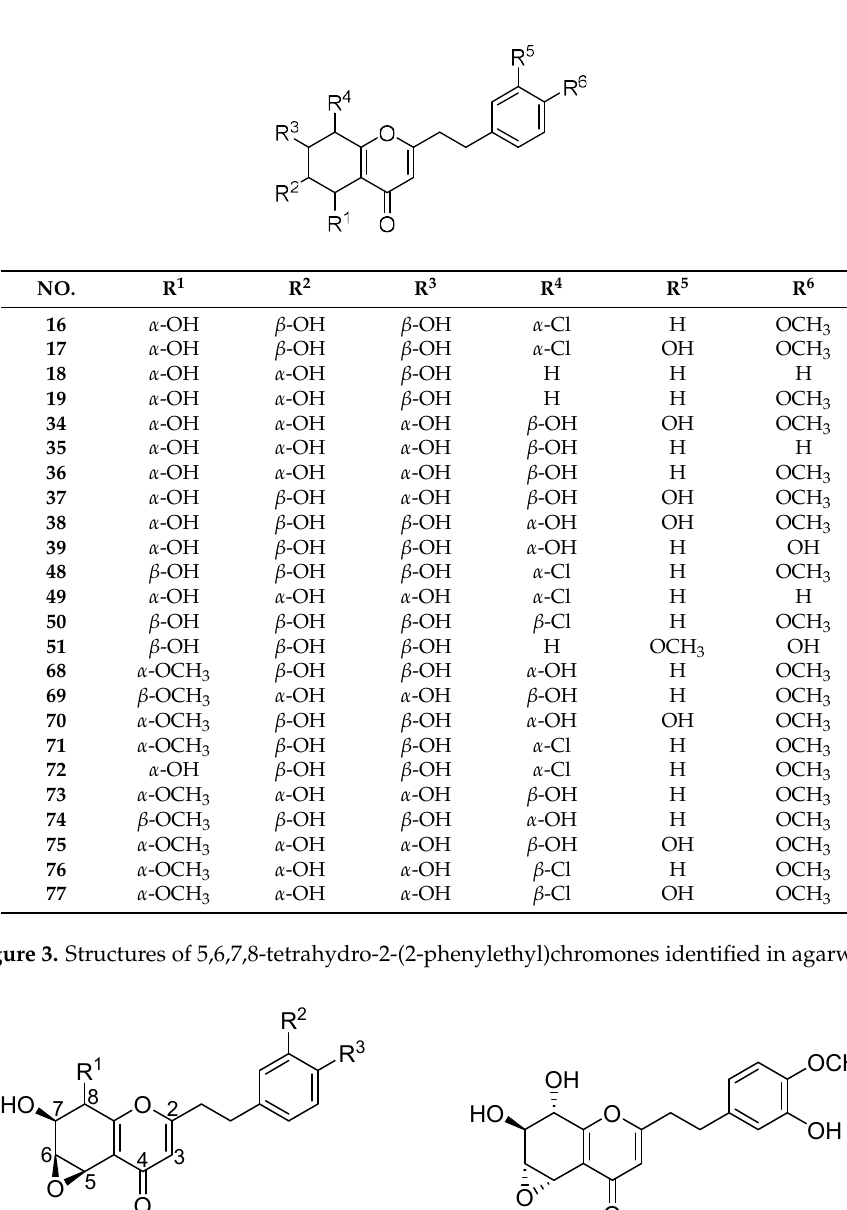
Figure 2. Structure of 2-(2-phenylethenyl)chromone identified in agarwood.